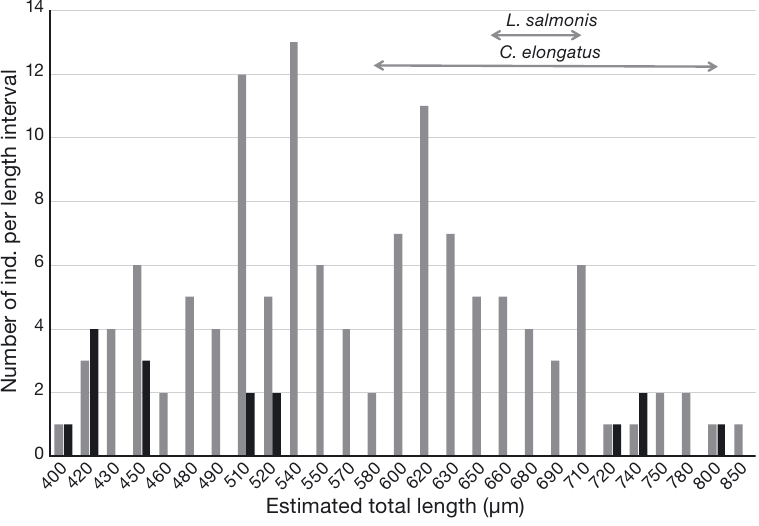
Fig. 3. Size distribution given as total body length measured on pelagic sea lice copepodids (n = 123) from Altafjorden in 2015 (gray bars) and Hardanger - fjorden in 2014 (black bars). For comparison, the published ranges of total length scales, 580 to 810 µm for Caligus elongatus (Piasecki 1996) and 658 to 709 µm for Lepeophtheirus salmonis (Schram 1993), are shown with